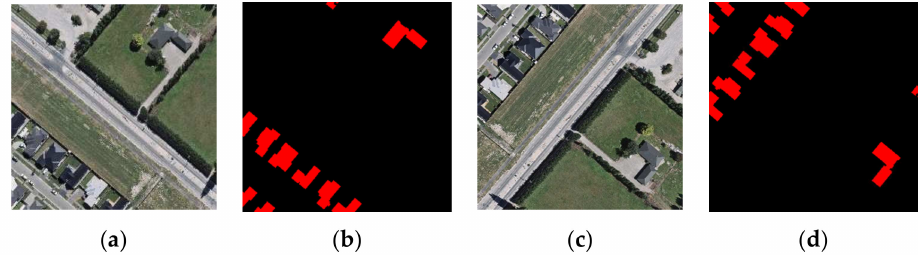
Figure 3. Image and label selected from WHU dataset: ( a , b ) show the image and label of the original images in the dataset, respectively; and ( c , d ) show the image and label after random rotation,